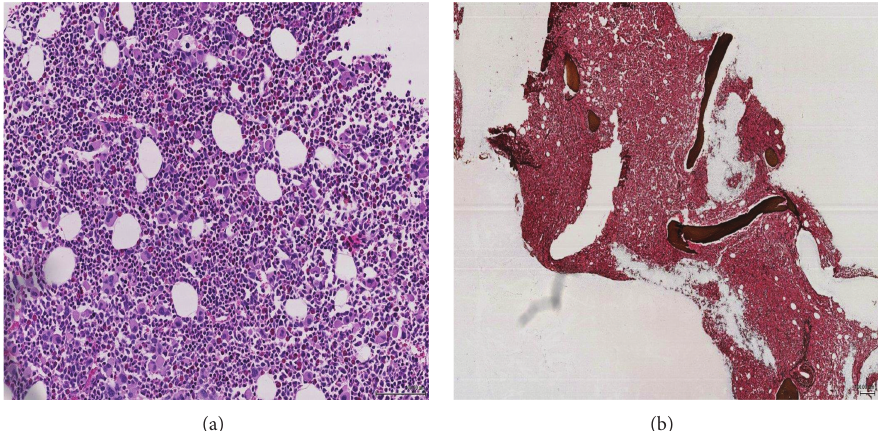
Figure 2: Trephine biopsy at BC progression showing (a) significant megakaryocytic hyperplasia and (b) grade II reticulin fibrosis.